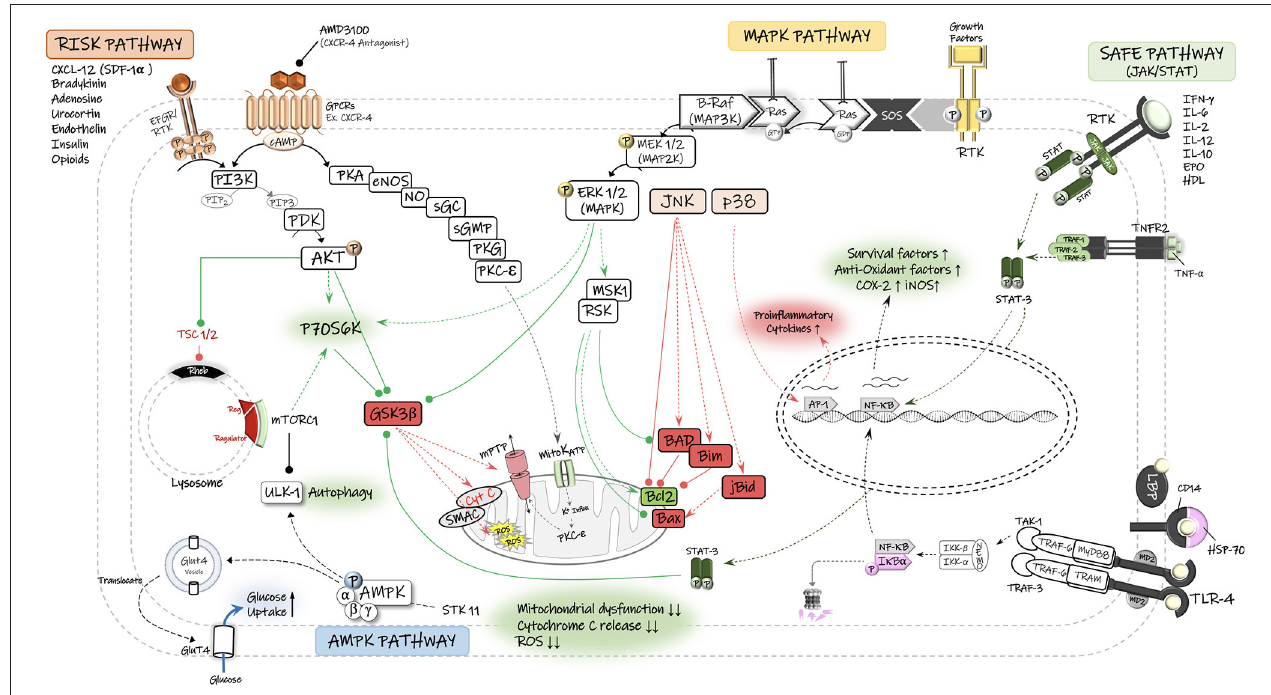
FIGURE 2 | Schematic diagram of the potential signaling pathways involved in neuroprotective effects of remote ischemic conditioning (RIC). The reperfusion injury salvage kinase (RISK) pathway and its major pro-survival kinases, including PI3-K, phosphatidylinositol 3-kinase; PDK, phosphoinositide-dependent protein kinase; AKT/PKB, protein kinase B. The survivor activating factor enhancement (SAFE) pathway and its major signaling components, including STAT, signal transducer and activator of transcription, JAK, Janus kinase. The Ras/Raf/M itogen-activated protein kinase/ERK kinase (MEK)/extracellular-signal-regulated kinase (ERK) cascade is activated through ligand binding to surface receptor. MAPK signal transduction results in activation of mitogen and stress activated kinase 1 (MSK1) and pp90 ribosomal S6 kinase (RSK), thereby leading to inactivation of the pro-apoptotic protein Bad and up-regulation of anti-apoptotic proteins of the Bcl-2 family. There is also an interplay between MAPK and RISK pathways that together with SAFE pathway converge on the mitochondrial permeability transition pore (mPTP) and prevent its opening and the consequent release of cytochrome C (Cyto C) and reactive oxygen species (ROS) into the cytosol. Under stress (Ischemia/hypoxia) conditions and low energy levels ( ↑ AMP:ATP), the cell energy sensor adenosine monophosphate-activated protein kinase (AMPK) gets phosphorylated and activated by its upstream serine/threonine kinase 11 (STK11) and enhances the translocation of glucose transporter GLUT4 to cell membrane. AMPK-dependent autophagy contributes to functional recovery and neuroprotection. Autophagy is also regulated by the mammalian target of rapamycin (mTOR) complex-1. TNF- α , tumor necrosis factors-alpha; TNFR2, tumor necrosis factors receptor type-2; RTK, receptor tyrosine kinase; mitoKATP, mitochondrial ATP-sensitive potassium channel; GSK3 β , glycogen synthase kinase 3 β ; GPCR, G protein-coupled receptor; P70S6K, p70 ribosomal S6 protein kinase; PKA, protein kinase A; PKC, protein kinase C; PKG, protein kinase G; cGMP, cyclic guanosine monophosphate; NO, nitric oxide; Ulk, autophagy-initiating kinase; TSC, tuberous sclerosis complex; Rheb GTPase, direct mTORC1 activator; AP-1, activator protein-1; JNK, c-Jun N-terminal kinase; NF- κ B, nuclear factor kappa B; TLR-4, toll-like